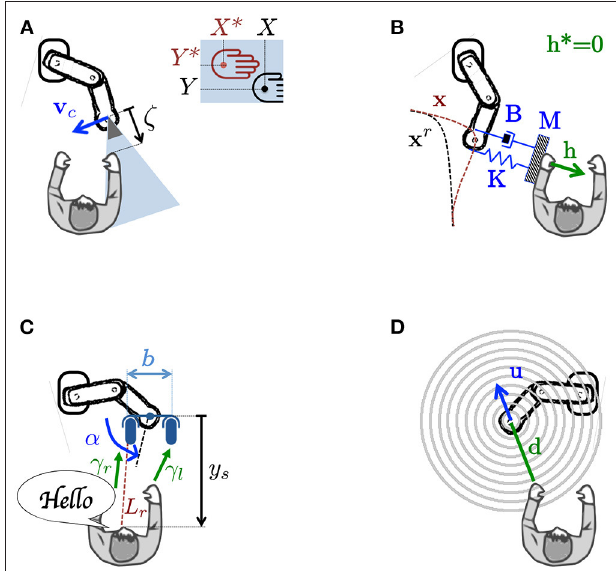
FIGURE 2 | Examples of four sensor-based servo controllers. (A) Visual servoing: the user hand is centered in the camera image. (B) Indirect force control: by applying a wrench, the user deviates the contact point away from a reference trajectory. (C) Audio-based control: a microphone rig is automatically oriented toward the sound source (the user’s mouth). (D) Distance-based control: the user acts as a repulsive force, related to his/her distance from the